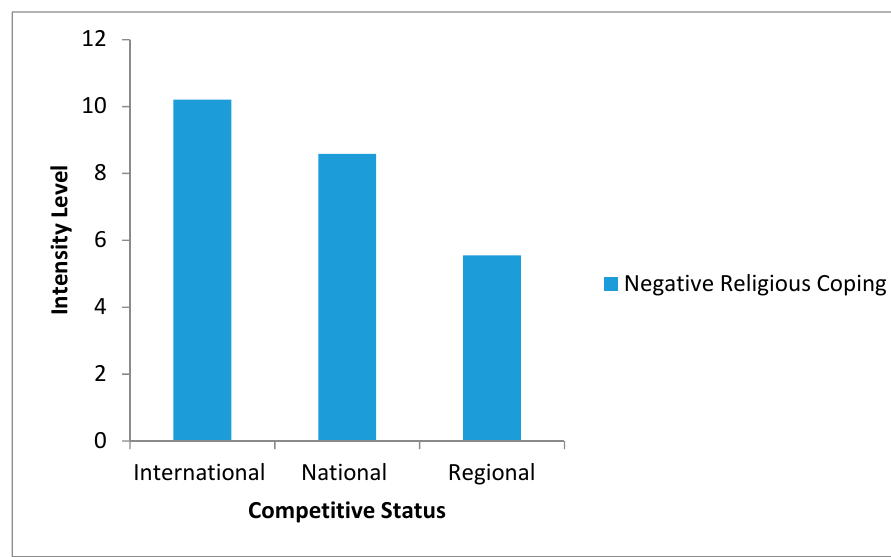
Figure 3. Student-athletes’ reported negative coping across competitive status.